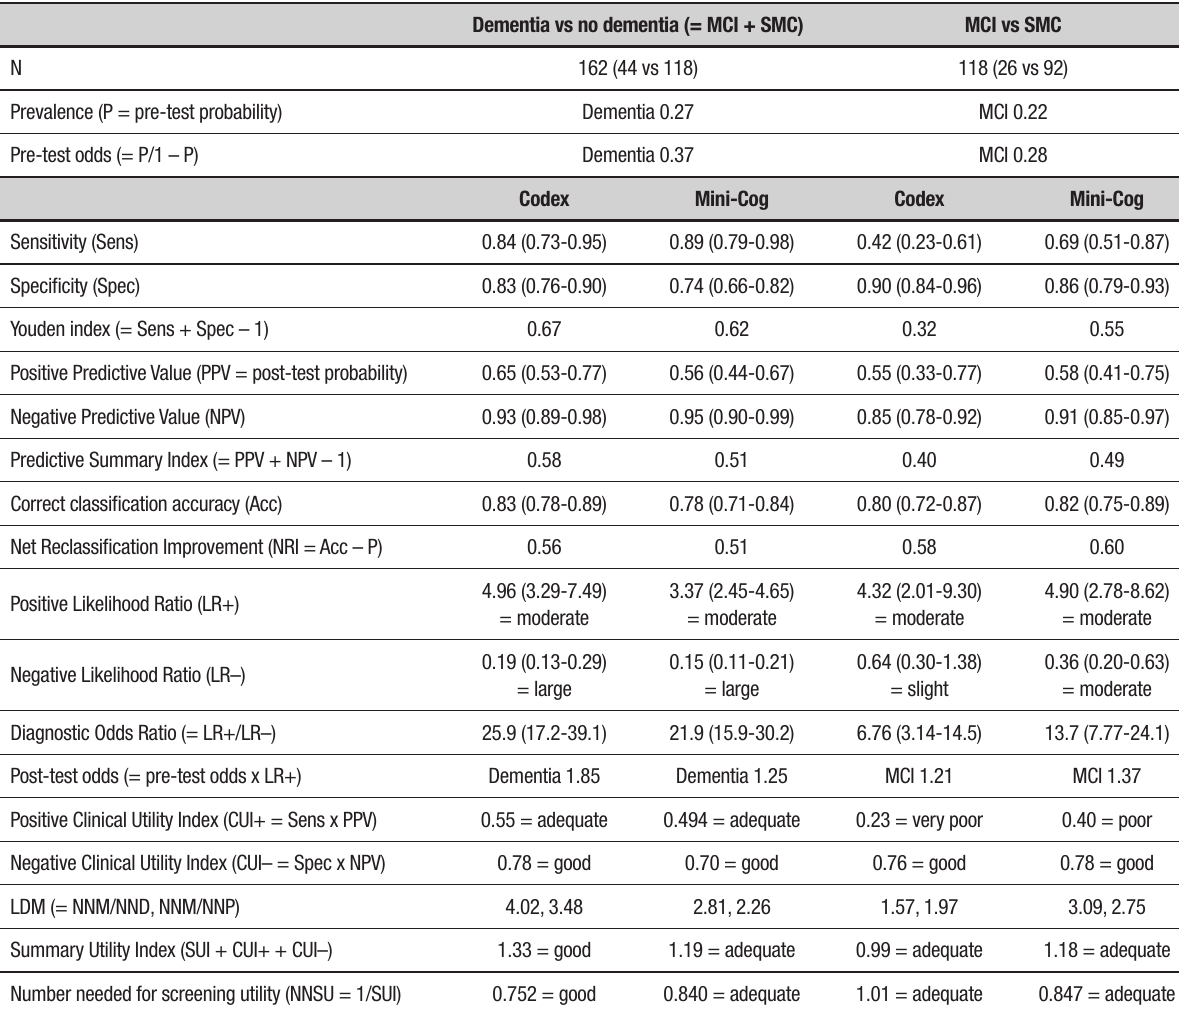
Table 3. Measures of discrimination (with 95% confidence intervals) for primary (diagnosis of dementia versus no dementia) and secondary (diagnosis of MCI versus subjective memory complaint [SMC]) study aims using Codex and